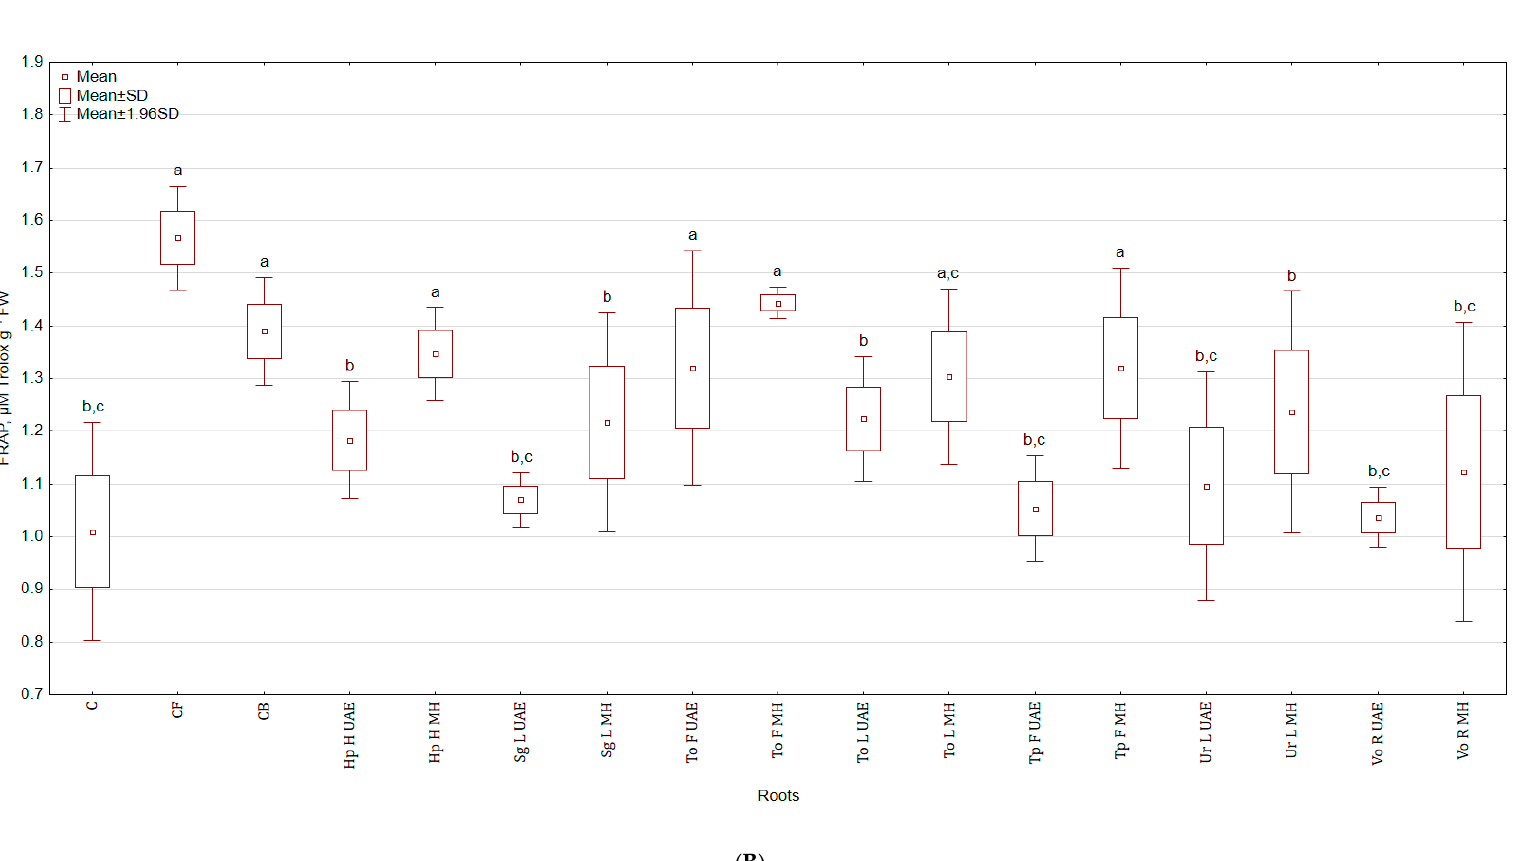
Figure 7. ( A ) Effect of the foliar application of botanical extracts on the antioxidant activity FRAP of celeriac leaves (N = 4). ( B ) Effect of the foliar application of botanical extracts on the antioxidant activity FRAP of celeriac roots (N = 4). (a) Statistically significant differences ( p < 0.05) between the control group (C) and extracts. (b) Statistically significant differences ( p < 0.05) between water formulation (CF) and extracts. (c) Statistically significant differences ( p < 0.05) between commercial biostimulant (CB) and extracts. 1st term of leaves rosette collection—samples taken for analyses 7 days after the second spraying. 2nd term of leaves rosette collection—samples taken for analyses after harvesting. Abbreviations: UAE, ultrasound assisted extraction; MH, mechanical homogenisation; Hp H, Hypericum perforatum L. (St. John’s wort, herb); Sg L, Solidago gigantea Ait. (giant goldenrod, leaf); To F, To L, Taraxacum officinale (L.) Weber ex F.H. Wigg (common dandelion, flower, leaf); Tp F, Trifolium pratense L. (red clover, flower); Ur L, Urtica dioica L. (nettle, leaf); Vo R, Valeriana officinalis L. (valerian, root).